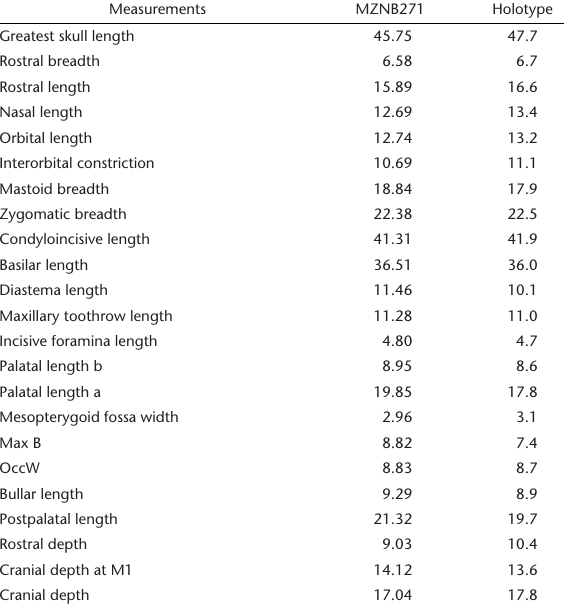
Table 1. Cranial measurements of Phyllomys lundi. Measurements of holotype (MN62392) are from L eite